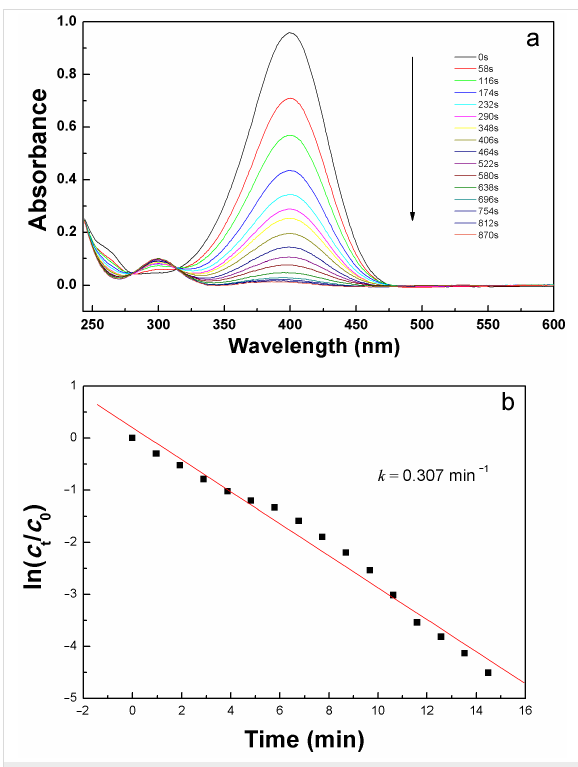
Figure 5: Catalytic performance of the AgNPs /SugPOP-1 composite. Time-dependent UV–vis spectral changes (a) and the kinetic curve (b) for the catalytic reduction of 4-nitrophenol (4-NP) to 4-aminophenol (4-AP) at room